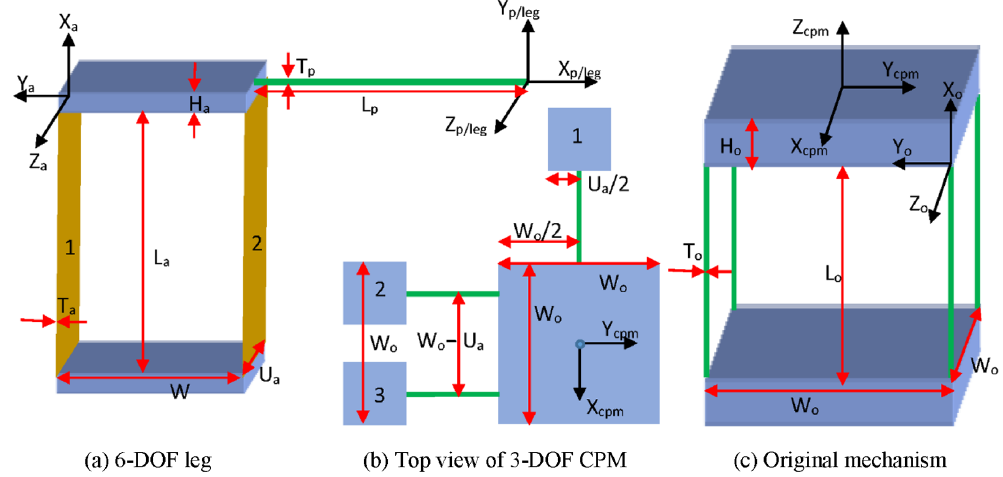
Figure 3. Geometry and coordinate system